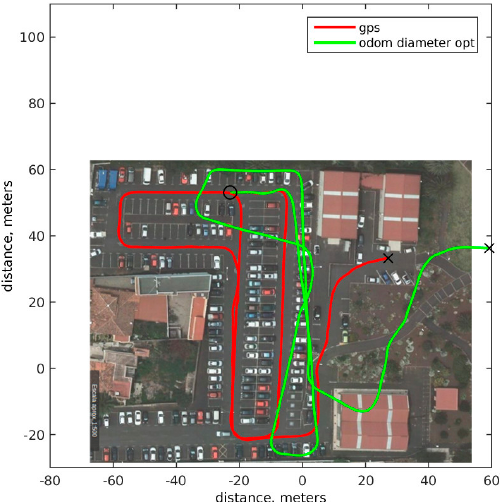
Figure 7. Optimization model including wheel radius change sensor; solid red ground truth based GPS, green, optimization result including radius.